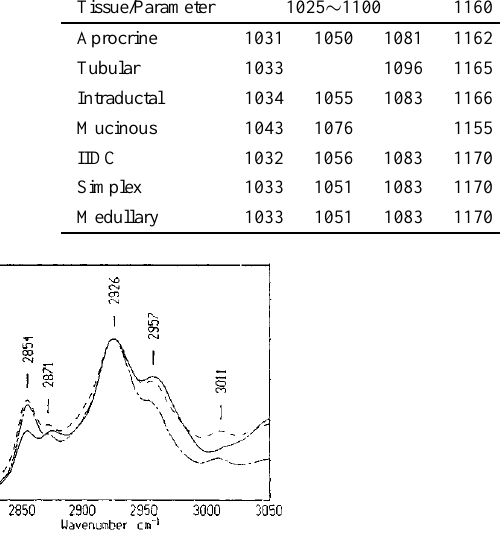
Fig. 5. This figure shows the differences of A 2958 = A 2853 : the ratio is the highest in (a) tubular carcinoma (—), almost similar in (b) other carcinomal tissues such as invasive infiltrating ductal medullary car- cinomal tissues (---), the smallest in (c) mucinous carcinoma (— - — -).